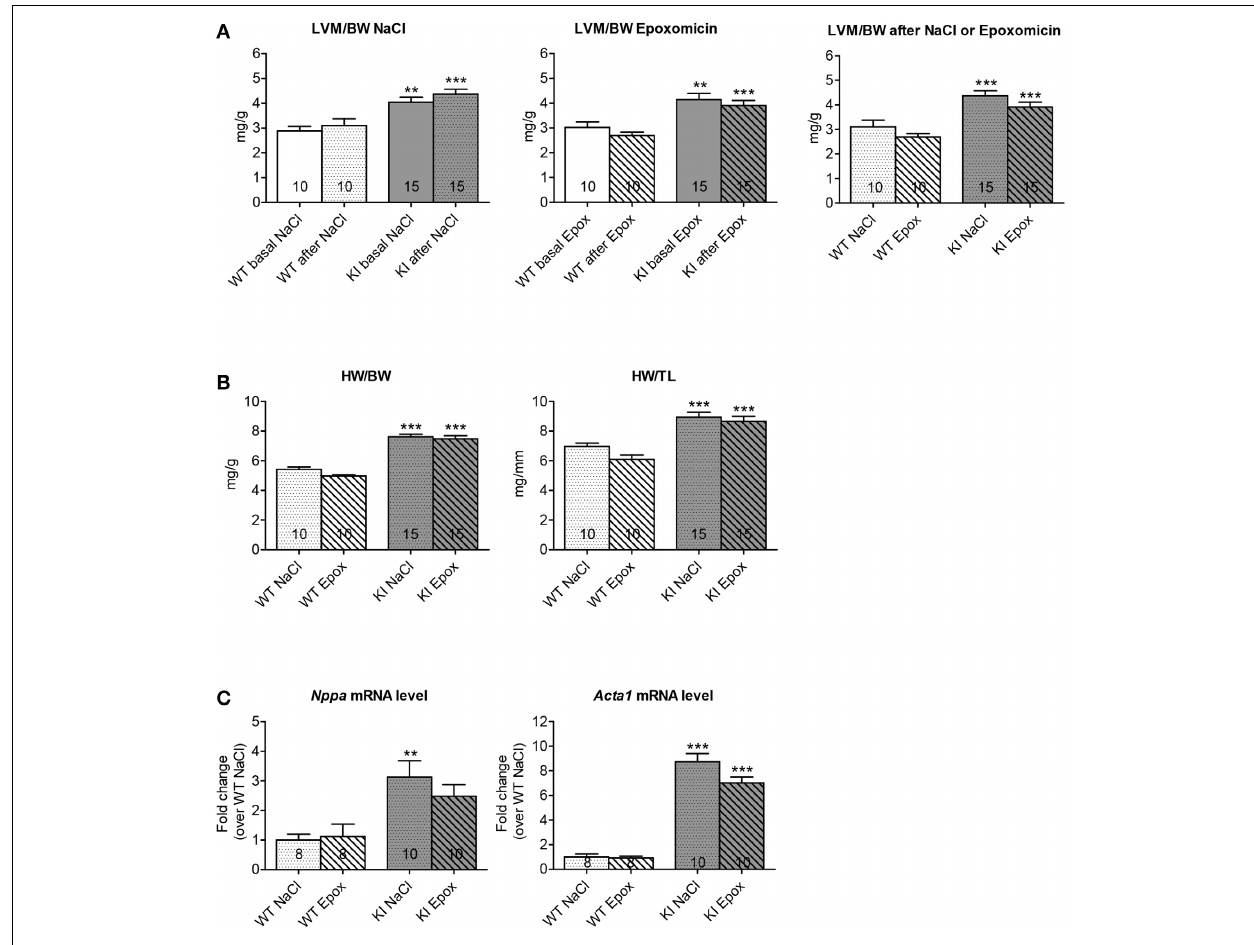
FIGURE 3 | Evaluation of cardiac hypertrophy after proteasome inhibition in KI vs. WT mice. Analyses were performed in KI (gray) and WT (white) mice under basal conditions (basal; plain) or after 1 week of treatment with epoxomicin (Epox; stripes) or sodium chloride (NaCl; dots) via osmotic minipumps. (A ) Left ventricular mass-to-body-weight ratio (LVM/BW) determined by echocardiography. (B ) Heart-weight-to-body-weight ratio